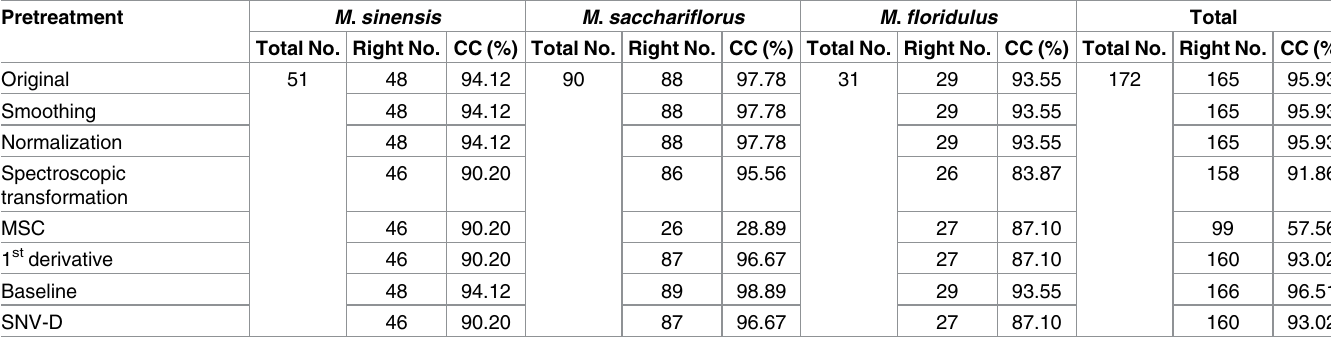
Table 2. Miscanthus classification based on the PLS models with different pretreatments in the full spectral range.